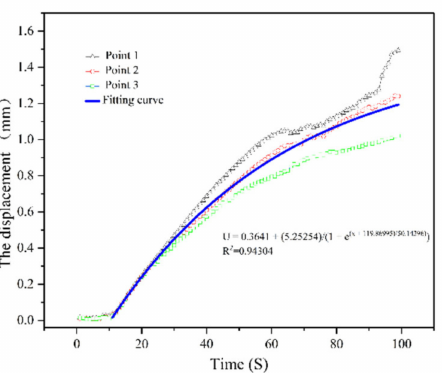
Figure 17. Diagram and fitting curve of displacement variation of the three marked points from Figure 16 with compressive time.